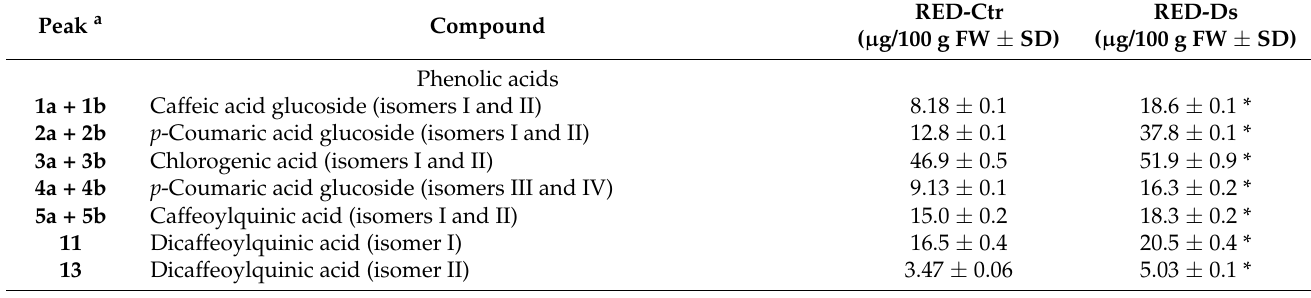
Table 2. Amount of constituents detected in peel extracts of plants grown in normal (RED-Ctr) and in drought stress (RED-Ds) conditions.